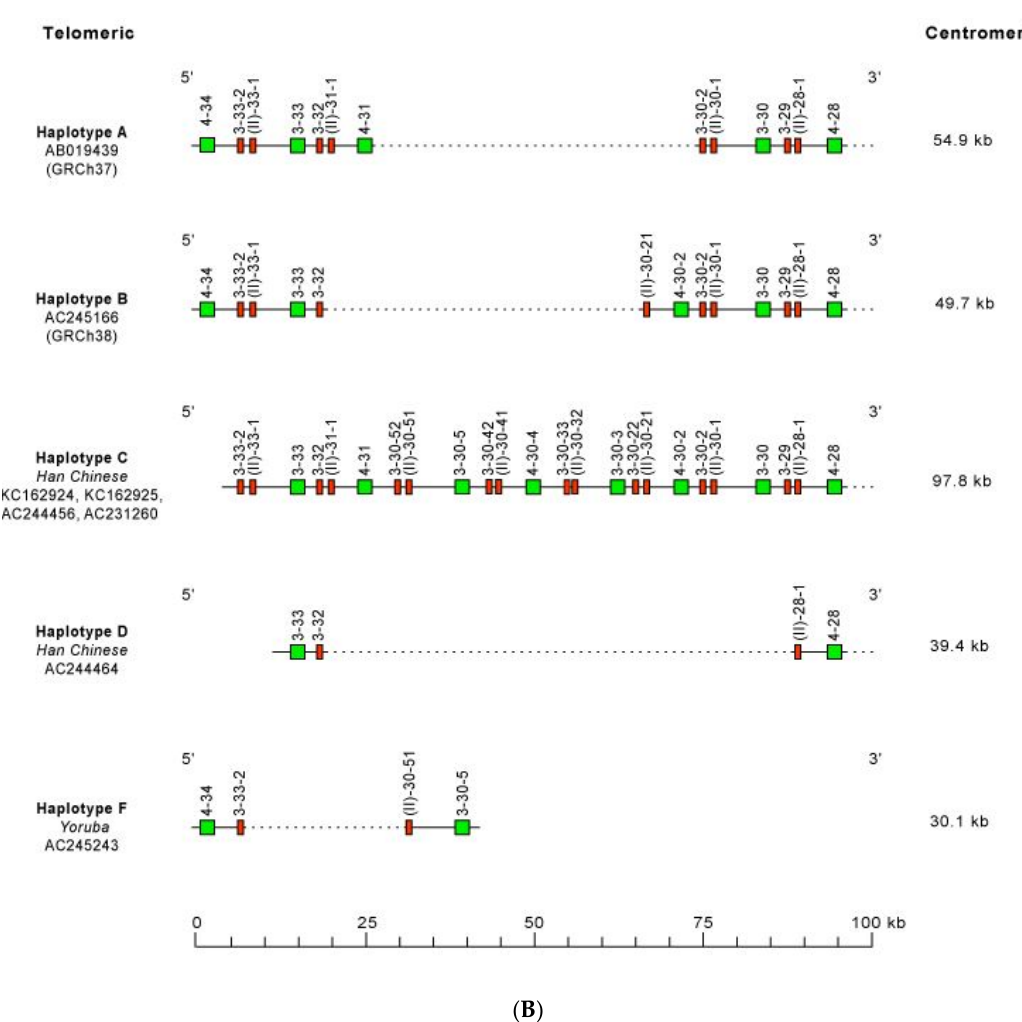
Figure 17. Multigene deletions and copy number variations (CNV) in the Homo sapiens IGH locus on chromosome 14 (14q32.33). ( A ). IGHC ‐ CNV deletions, either identical or different, on both chromosomes, designed I to VI according to the chronogical order in which they were found. Deletion I, first identified by the absence of the Gm1 allotypes in a 70 ‐ year old healthy Tunisian woman (TAK3), homozygous for that deletion [113,114] allowed the ordering of the Homo sapiens IGHC genes in the IGH locus [174,175]. Deletions I and II [113–115], found in healthy individuals from consanguinesous families, involve highly homologous spots of recombination [176] , as also described in an healthy individual (T17) homozygous for deletion III and lacking IgA1, IgG2, IgG4 and IgE [116]. ( B ). Polymorphisms by insertion/deletion between IGHV4 ‐ 34 and IGHV4 ‐ 28 (haplotypes A to F). The distance between IGHV4 ‐ 34 and IGHV4 ‐ 28 (sequence length shown by the regular line) is indicated in kilobases (kb) for each haplotype. Haplotype A is from GRCh37 and corresponds to the main line of IMGT Locus Representation [2]. Haplotype B is from GRCh38 and corresponds to BAC clone sequences [247] from the CHORI ‐ 17 BAC library. Dotted lines indicate missing genes compared to the haplotype C. (With permission from M ‐ P. Lefranc and G. Lefranc, LIGM, Founders and Authors of